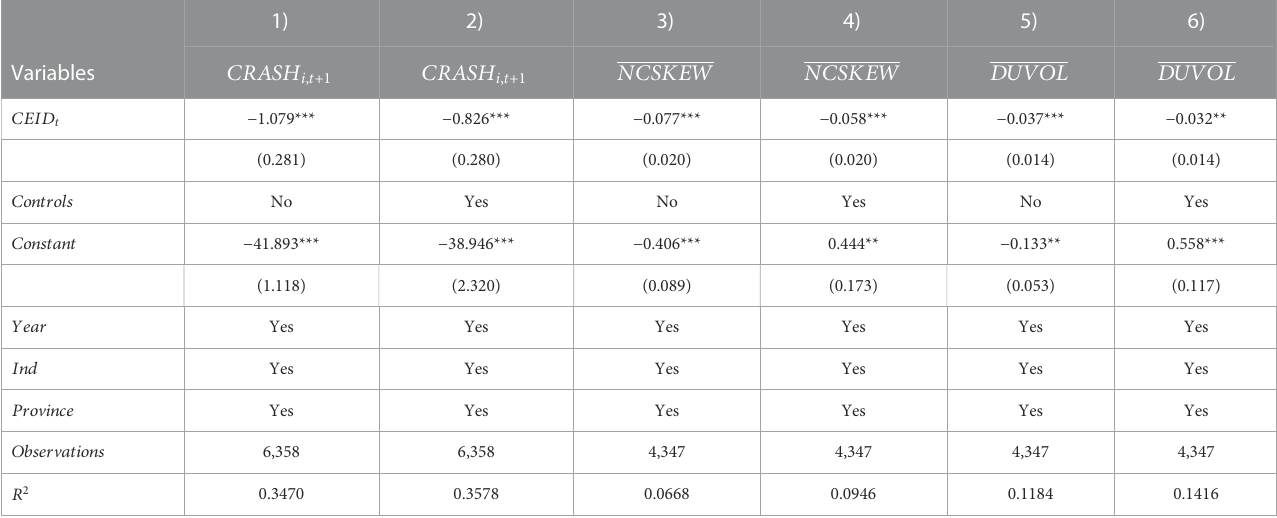
TABLE 7 Substitution variable.